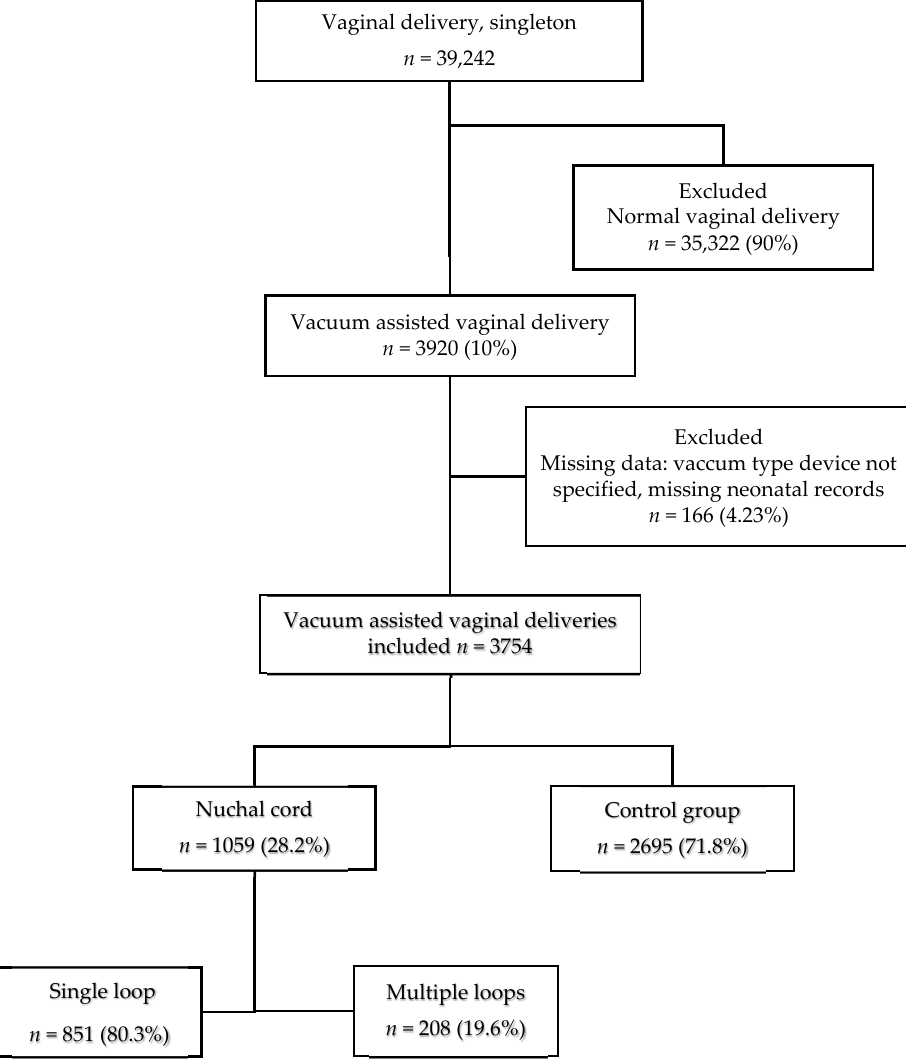
Figure 1. Flow diagram of study participants.